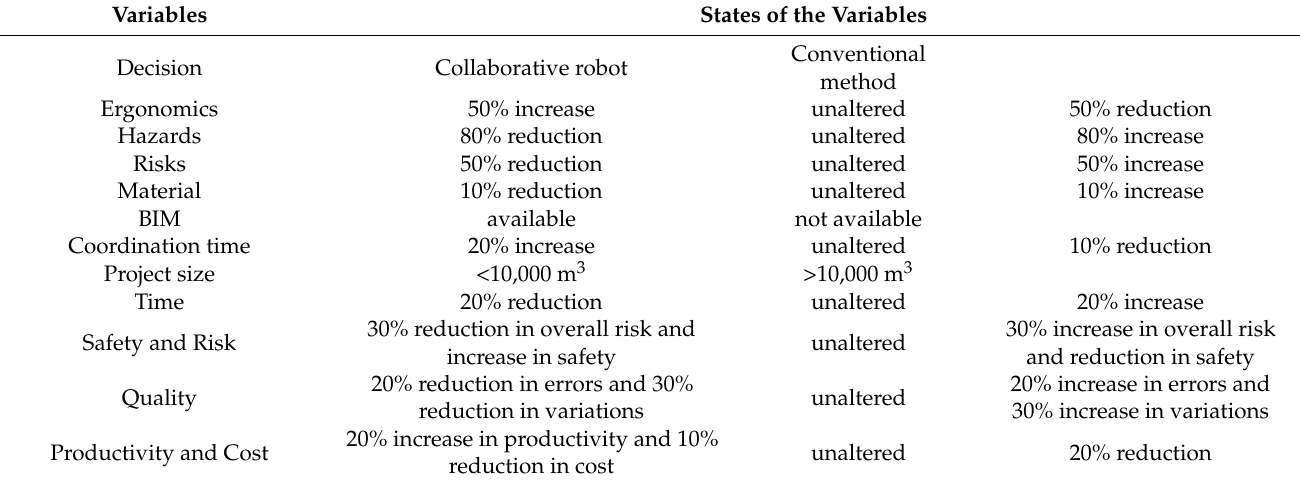
Table 3. Variables to be considered for UC4—marking and spraying.